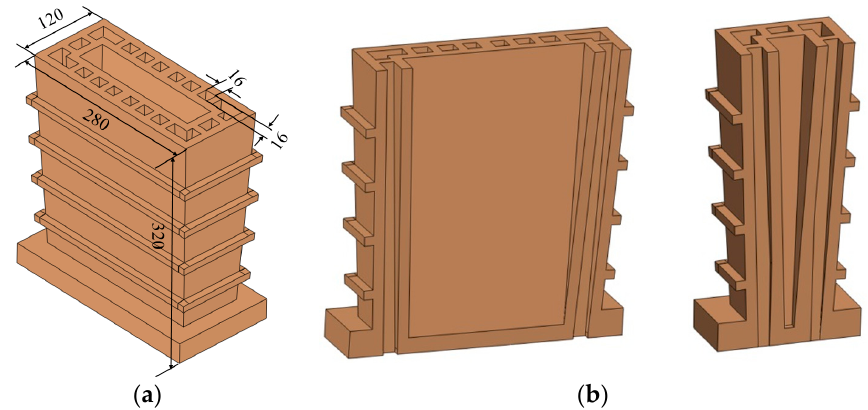
Figure 5. Designed hollow sand mold with chimneys: ( a ) overall perspective view and ( b ) partial sectional view (unit: mm).